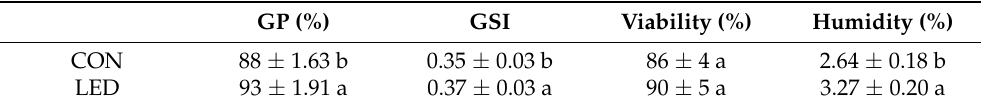
Table 1. Germination percentage (GP), germination speed index (GSI), percentage of seed viability, and percentage of seed humidity in Control (CON, unlighted) and irradiated R LED (LED) pepper seeds, after radicle emergence and growth during germination (after 96 h of imbibition). Values are means ± SE ( n = 5). The different letters indicate significant differences among treatments according to Tukey’s test ( p <